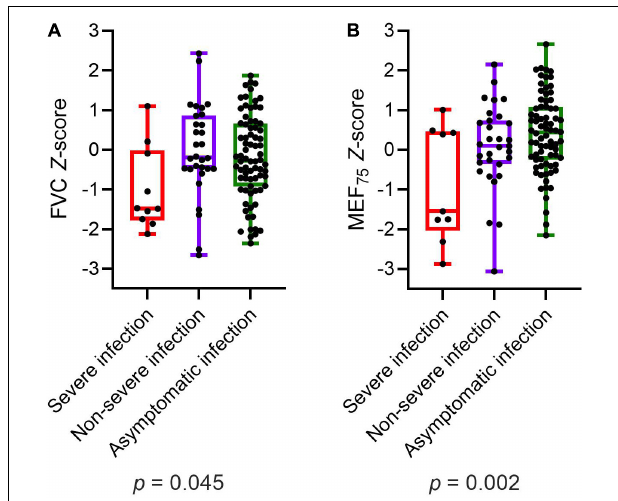
FIGURE 2 | Depiction of (A) FVC Z -score and (B) MEF 75 Z -score of all participants (COVID-19 and controls) divided into severe, non-severe and asymptomatic infection, respectively no infection in the control group. Boxplots show medians, quartiles, minimum and maximum values. The dots represent the individual values of participants. Differences were considered statistically significant at p ≤ 0.05. FVC, Forced Vital Capacity; MEF 75 , Mean Expiratory Flow at 75%.